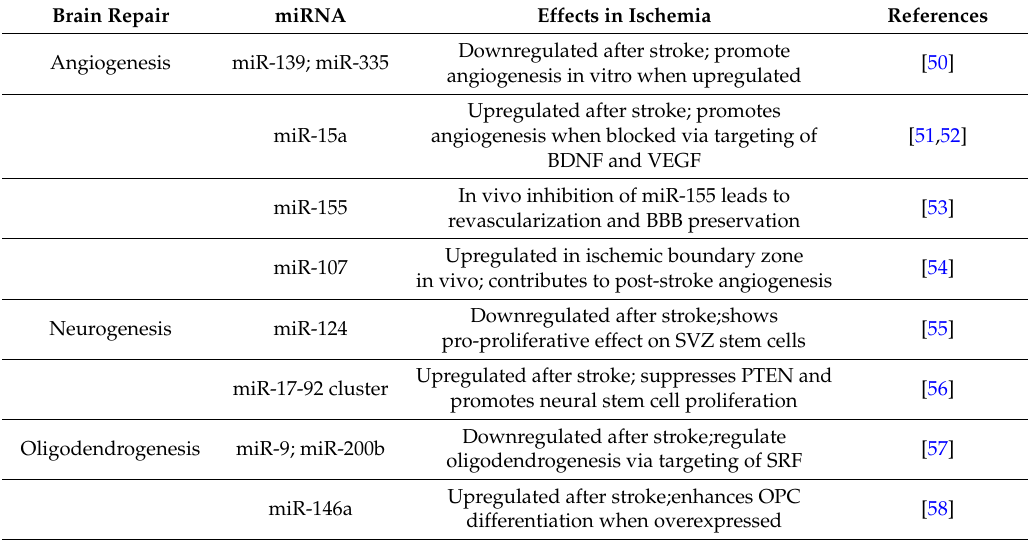
Table 1. Key miRNAs altered by stroke and their potential roles in ischemic brain repair processes. Brain